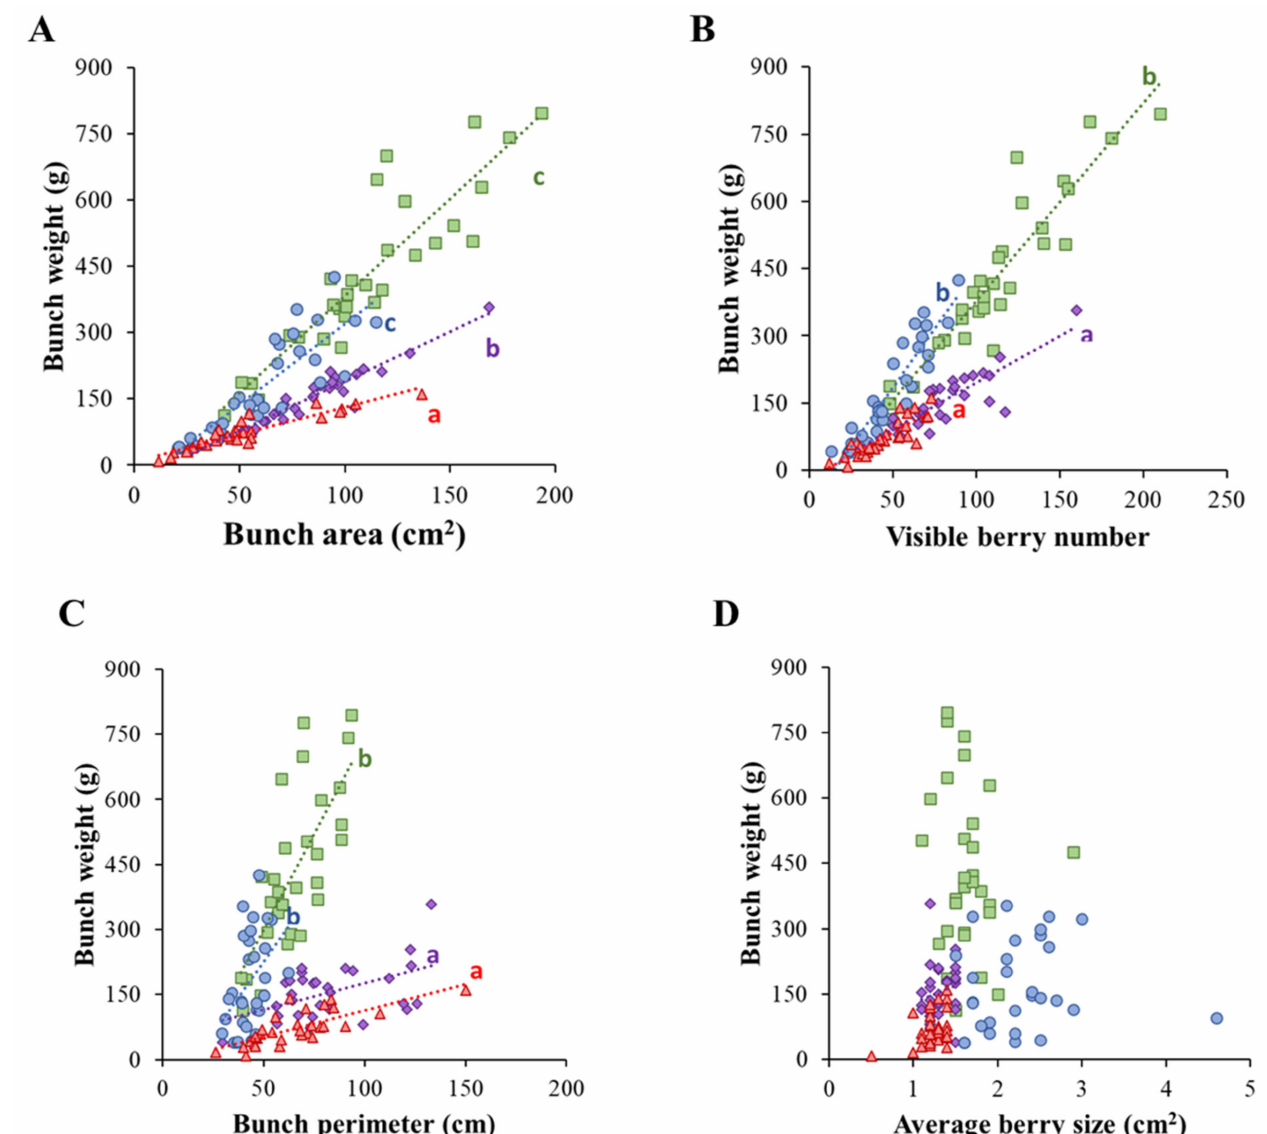
Figure 3. Scatter plots showing the fitted linear relationships between bunch weight (predictor) and bunch area ( A ), visible berry number ( B ), bunch perimeter ( C ), and average berry area ( D ) on the training data set. Marker colors: green squares = Arinto ; purple diamonds = Cabernet ; blue circles = Encruzado ; red triangles = Syrah . Different letters near the regression lines indicate significant differences among slopes according to Student’s T-test at p ≤ 0.05. When R 2 is not significant, regression lines are not shown on the